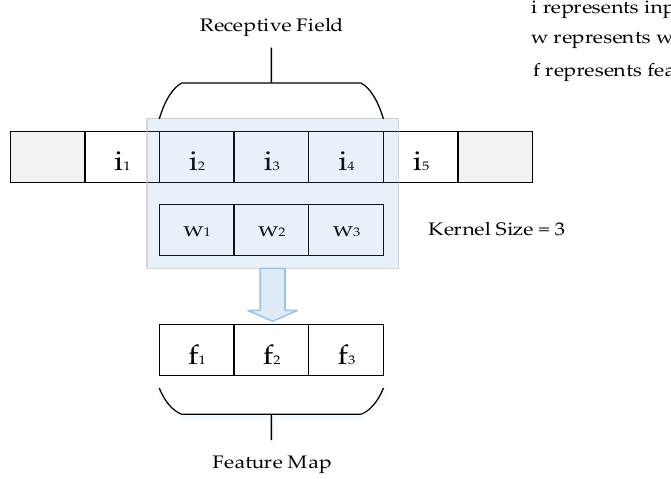
Figure 4. Example of 1-D convolution operation.